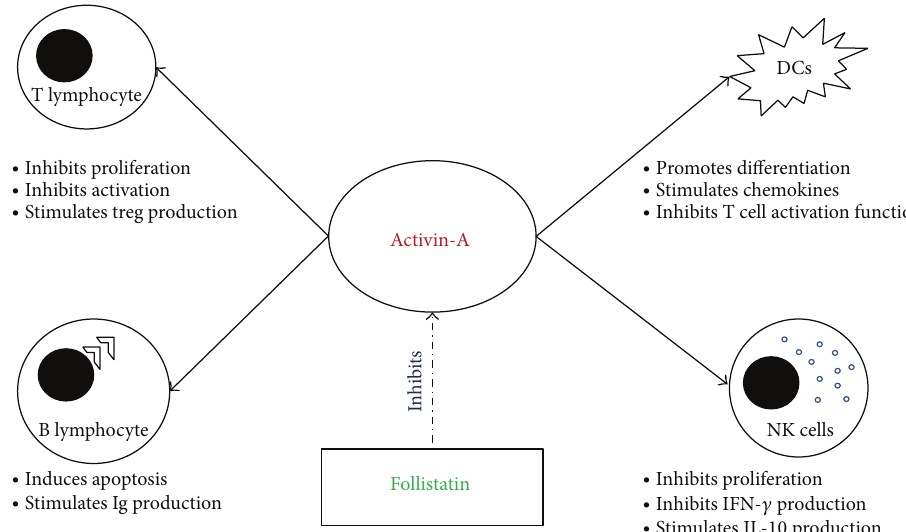
Figure 2: The role(s) of activin-A in the regulation of major immune cells involved in the immune response against hepatitis C virus. The actions of activin-A are inhibited by